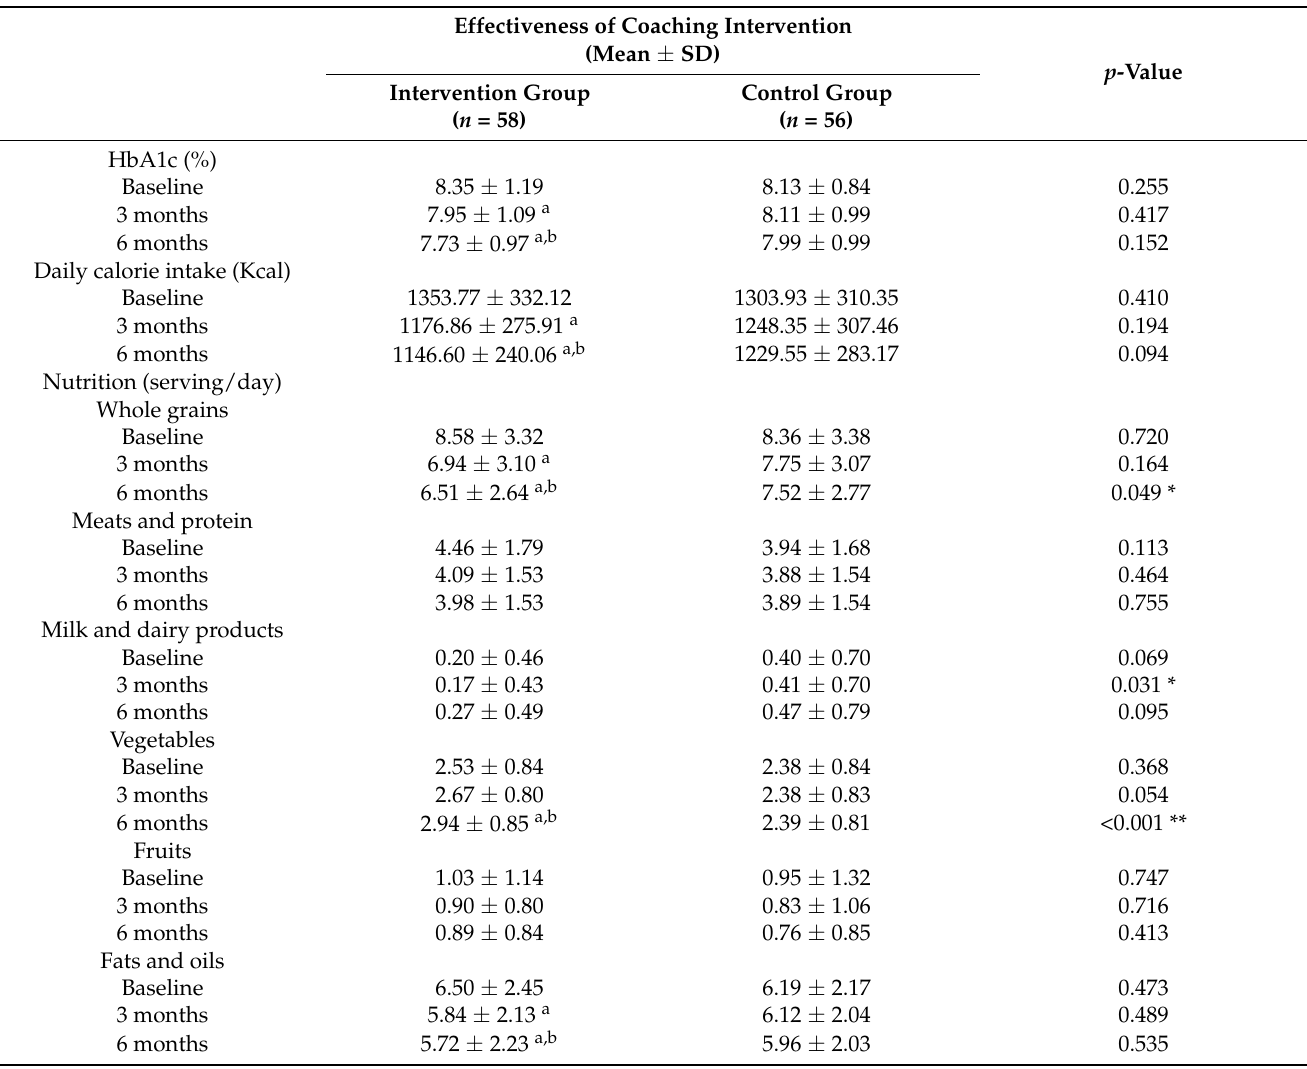
Table 2. Effectiveness of coaching intervention of study groups according to ANCOVA test and repeated-measured ANOVA